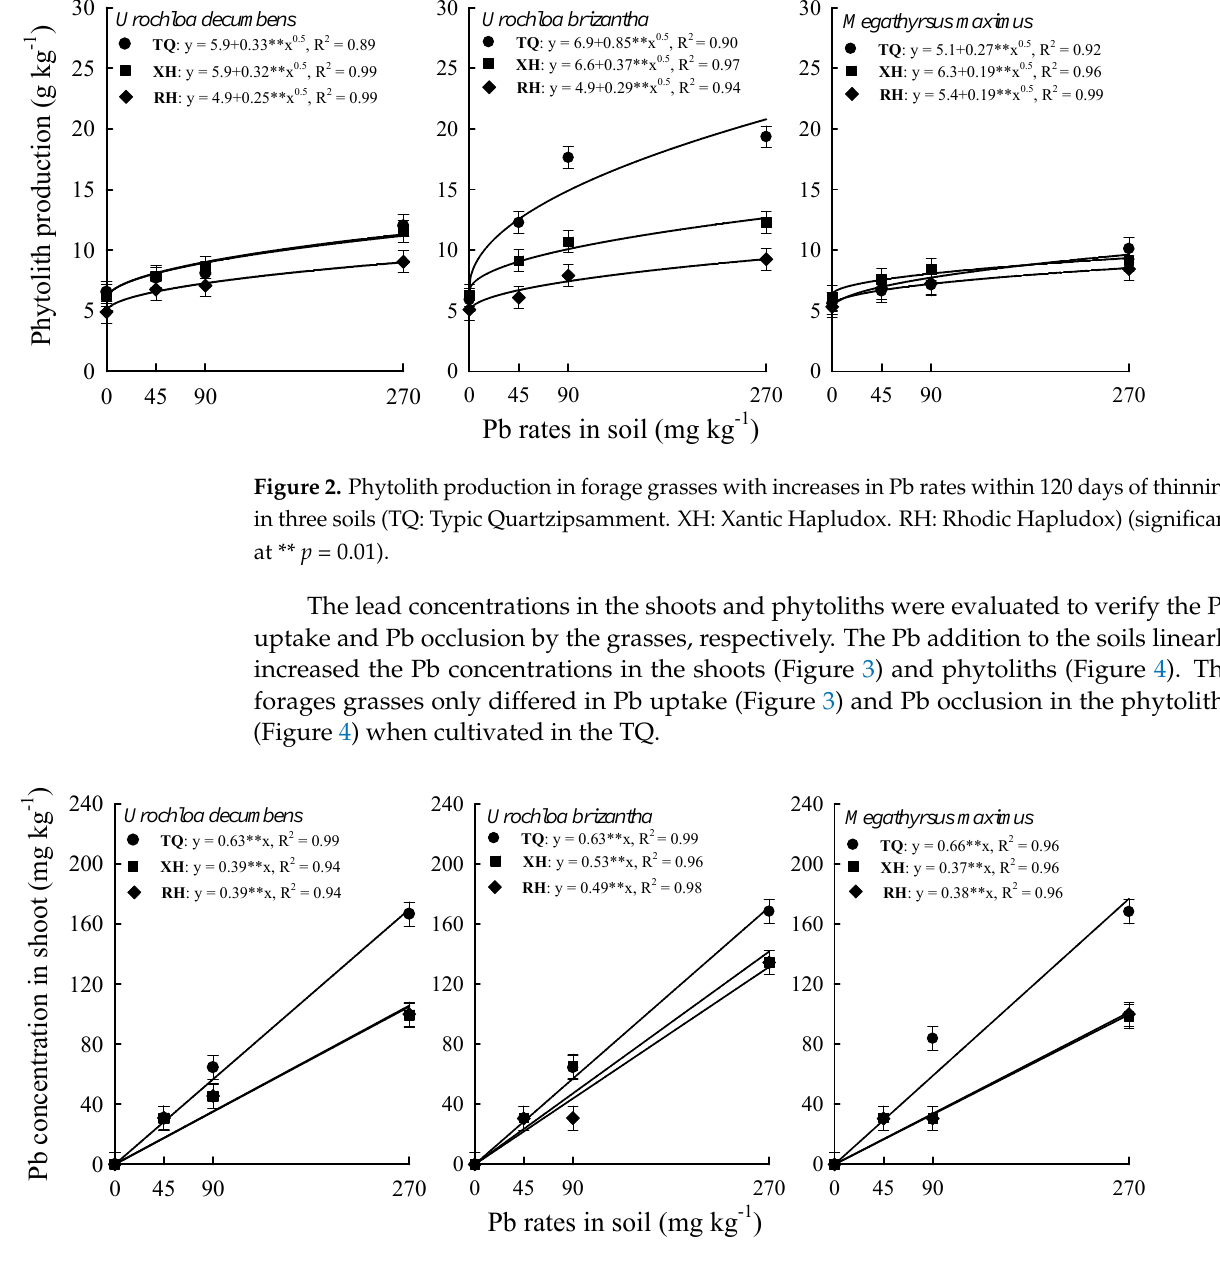
Figure 3. Pb concentrations in shoots of forage grasses with increases in Pb rates within 120 days of thinning in three soils (TQ: Typic Quartzipsamment. XH: Xantic Hapludox. RH: Rhodic Hapludox) (significant at ** p = 0.01).